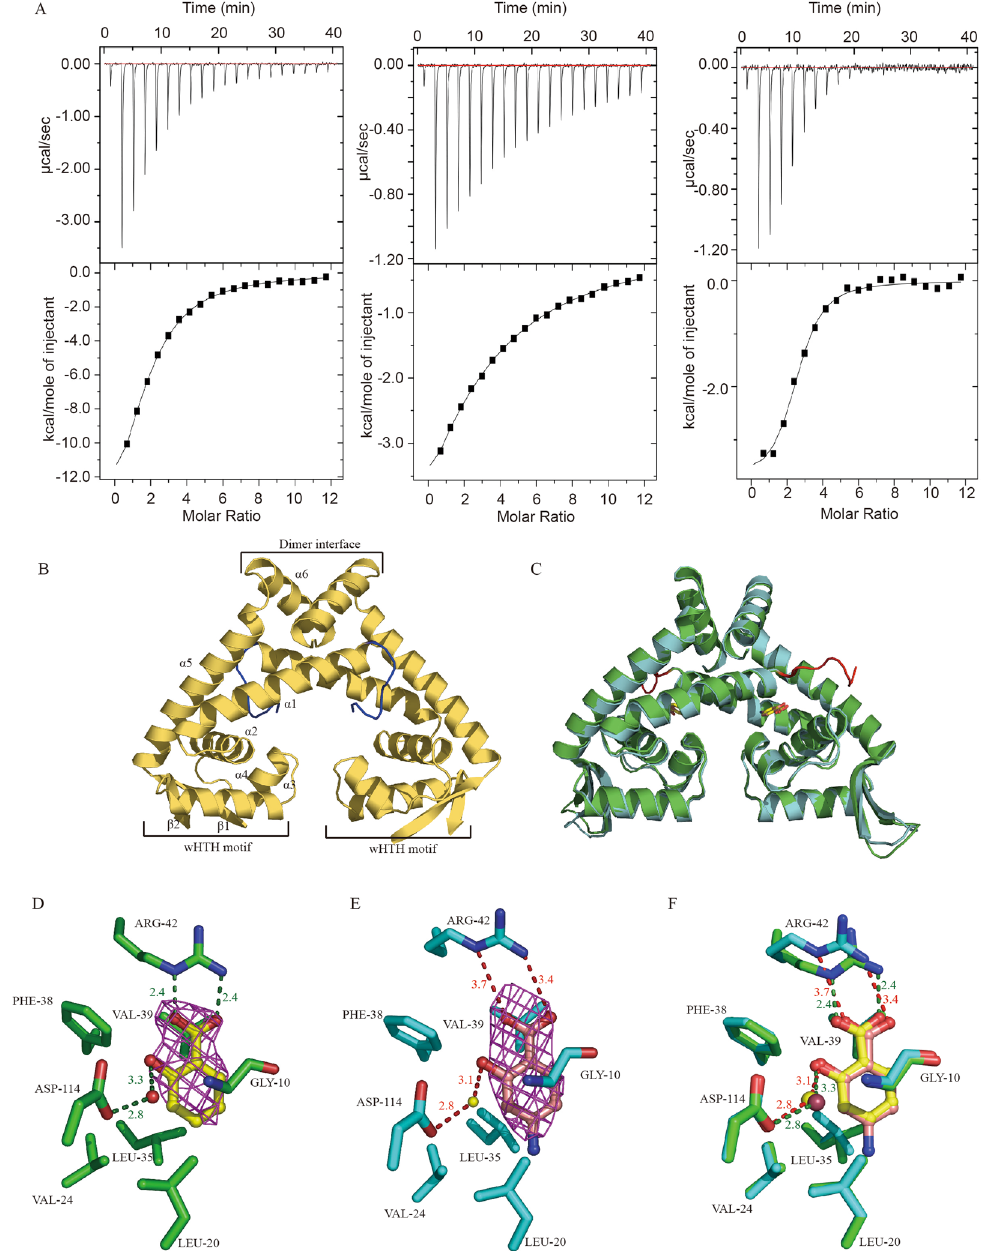
Figure 2. Rv2887-SA and Rv2887-PAS complex structures show that SA and PAS bind to Rv2887 in a similar manner ( A ) Representative binding isotherms of SA (left) PAS (centre) and gemfibrozil (right) titrated into Rv2887, as determined by isothermal titration calorimetry. ( B ) Secondary structure of apo Rv2887. Elements of one of the subunits, the dimerization interface and the winged helix-turn-helix motif (wHTH) are labelled. ( C ) Secondary structure superposition of the Rv2887-PAS dimer (blue) and the Rv2887-SA dimer (green). ( D ) Stereo image of the SA binding pocket; residues from Rv2887 are shown as sticks. Polar contacts are shown as green dashed lines, and the red sphere is a water molecule. ( E ) Stereo image of the PAS binding pocket; residues from Rv2887 are shown as sticks. Ligands SA and PAS are surrounded by ligand-omit 1Fo-Fc electron density maps (magenta) contoured and 3.0 σ . Polar contacts are shown as red dashed lines, and the yellow sphere is a water molecule. ( F ) Stereo image of the superposition of the PAS binding pocket and the SA binding